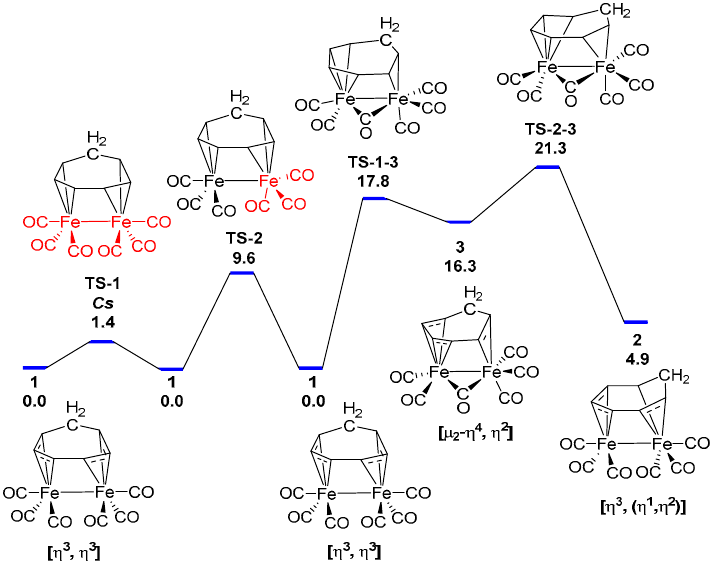
Figure 2. Interconversions of the C 1 symmetrical (C 7 H 8 )Fe 2 (CO) 6 . All Gibbs energies are relative to complex 1. to complex 1